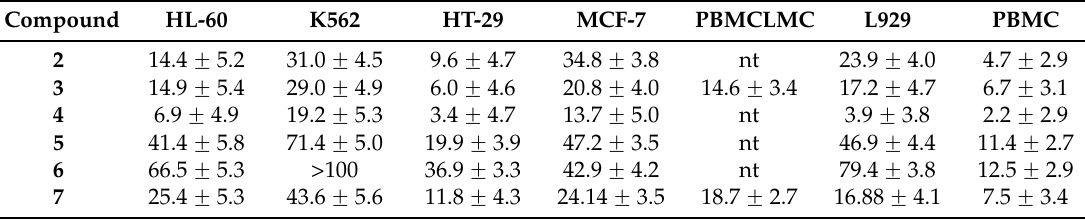
Table 2. Inhibitory effect of compounds and etoposide on cell growth of human cancer and normal cell lines after 72 h of